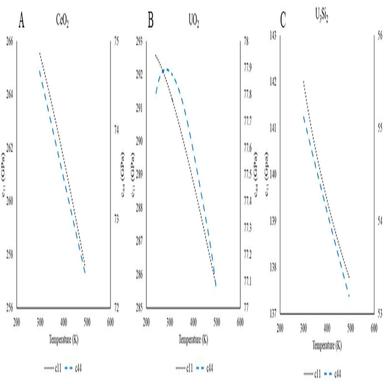
The temperature-dependent elastic constants of (A) CeO2, (B) UO2, and (C) U3Si2 as measured using RUS.